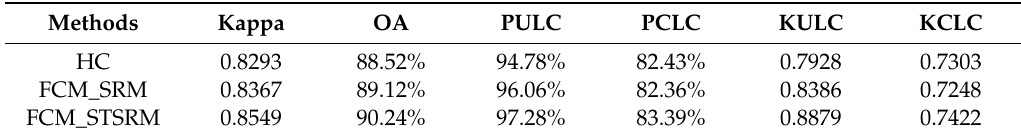
Table 3. Accuracy statistics of different